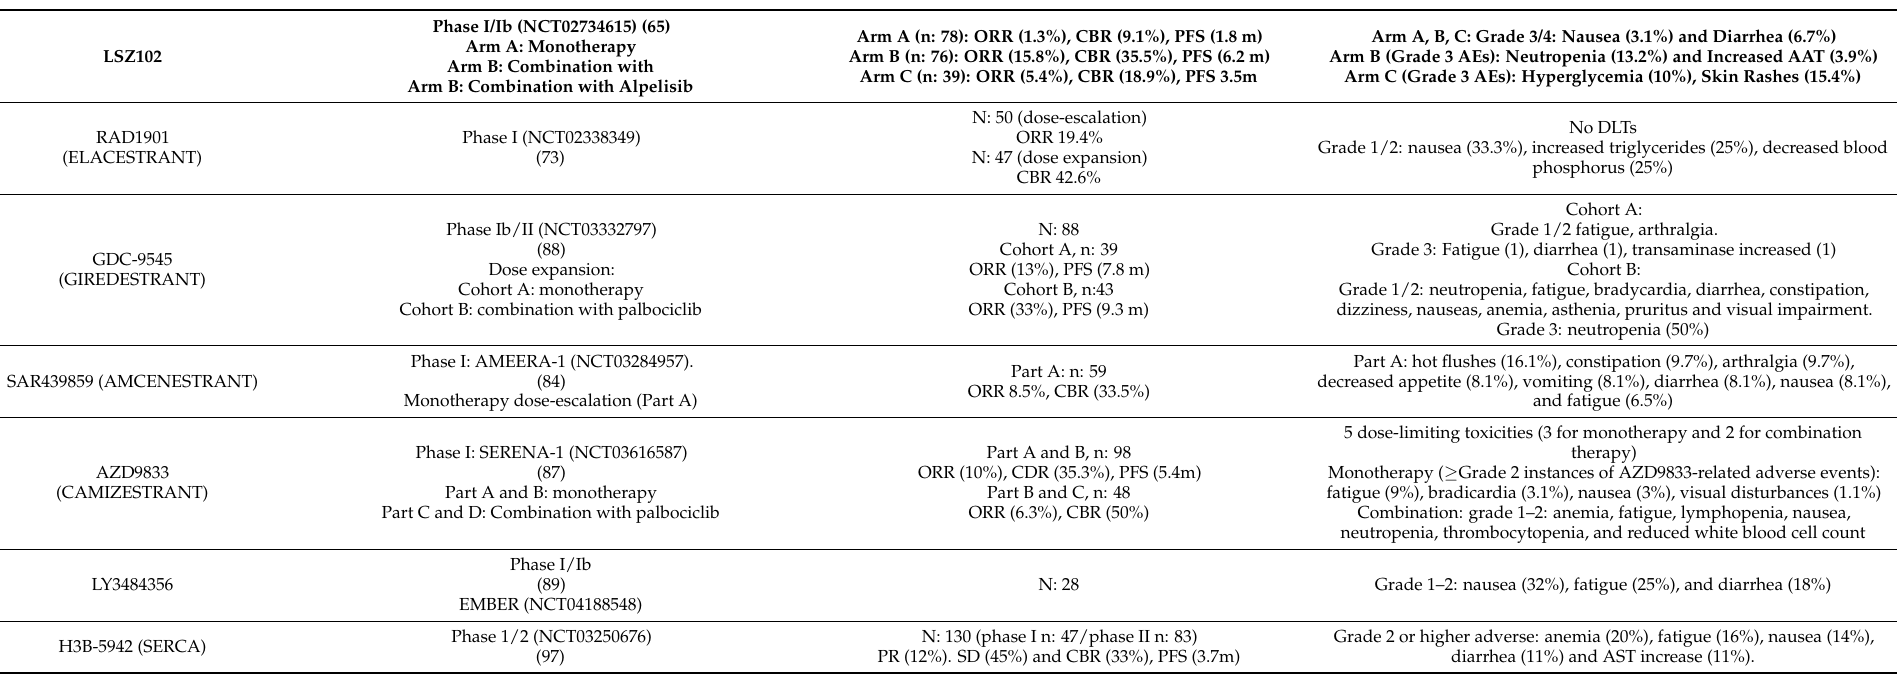
Table 2. Reported efficacy and toxicity: Efficacious ER target engagement and promising clinical activity was shown in early-phase clinical trials with a good toxicity profile but clinical efficacy needs to be confirmed in larger patient